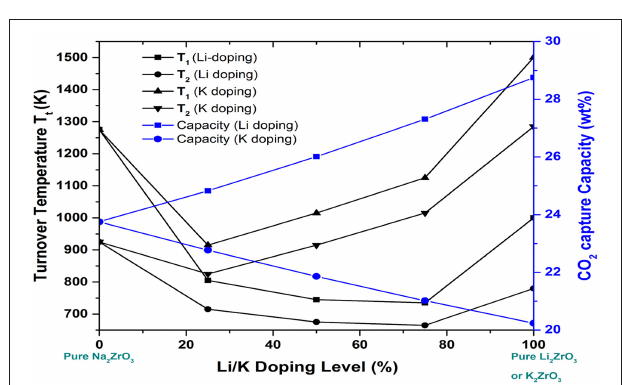
FIGURE 7 | The dependence of the turnover temperatures and CO 2 capture capacity on Li/K doping molar percentage in Na x M 2 − x ZrO 3 (M = Li, K). T 1 is the turnover temperatures under pre-combustion conditions with CO 2 partial pressure at 20 bars, while T 2 is the turnover temperatures under post-combustion conditions with CO 2 partial pressure at 0.1 bar.